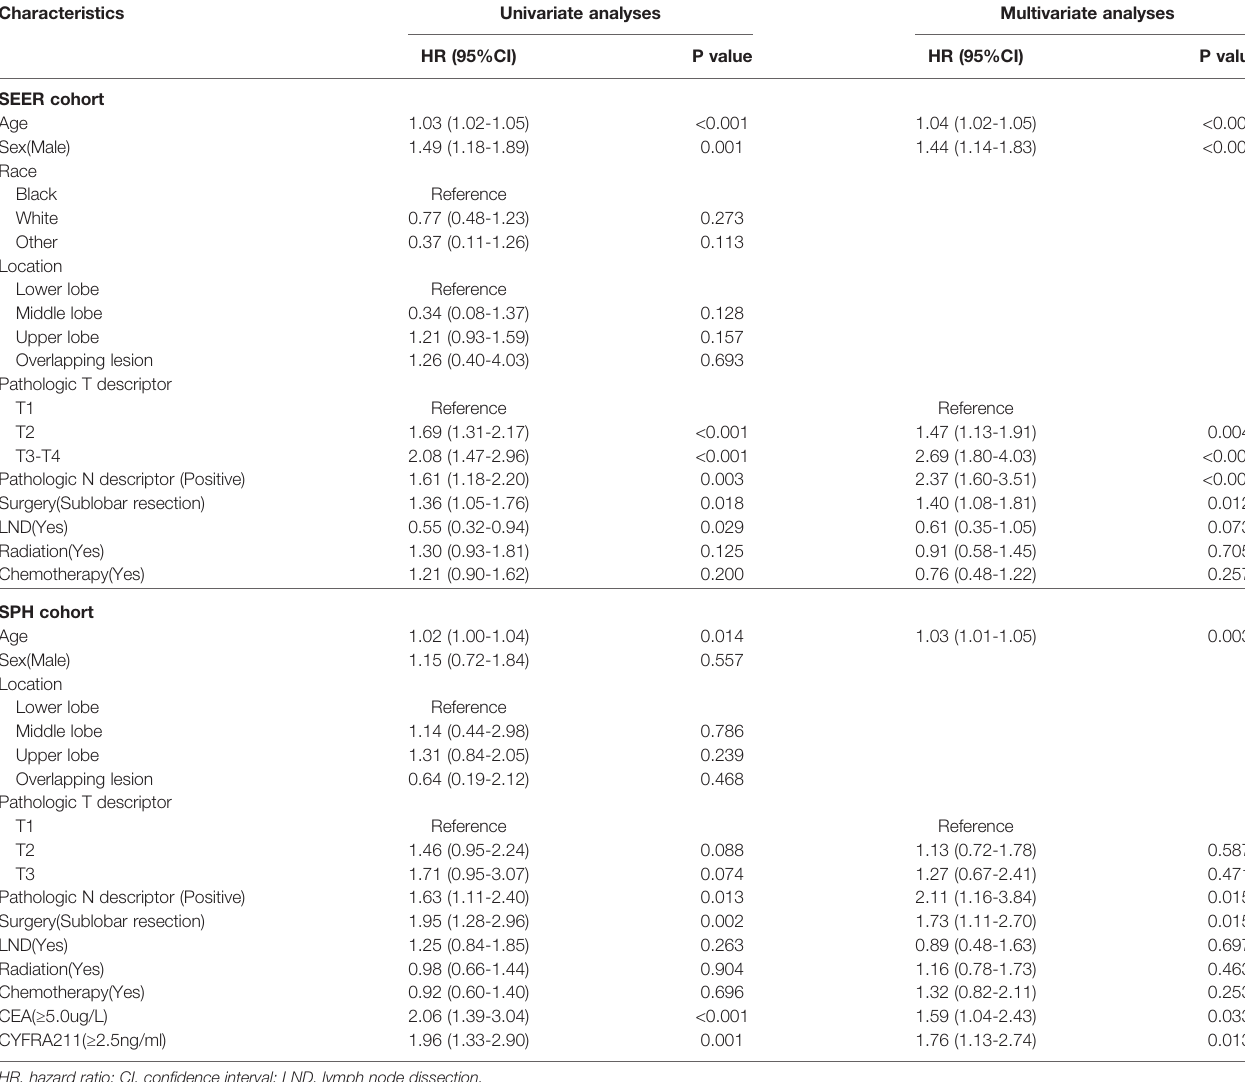
TABLE 3 | Univariate and multivariate analyses for overall survival. Characteristics